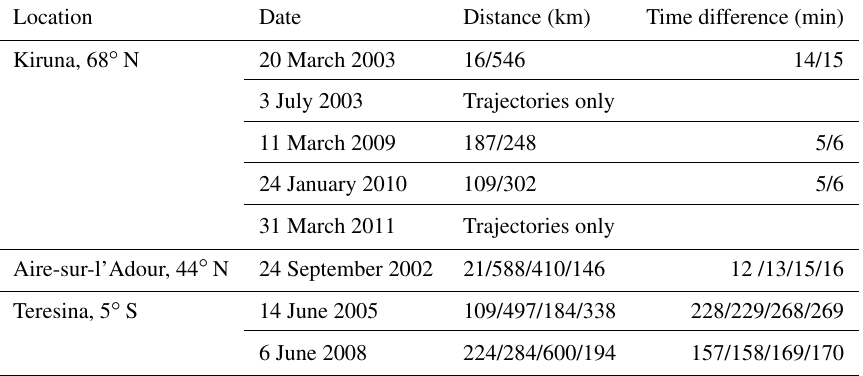
Table 3. Overview of MIPAS balloon flights used for intercomparison with MIPAS-E. Distances and times between closest trace gas profile pairs observed by MIPAS-E and the validation instrument refer to an altitude of 20km (Kiruna) and 30km (Aire-sur-l’Adour and Teresina). In addition, the 2d forward and backward trajectories were calculated for each balloon flight to search for further matches with the satellite